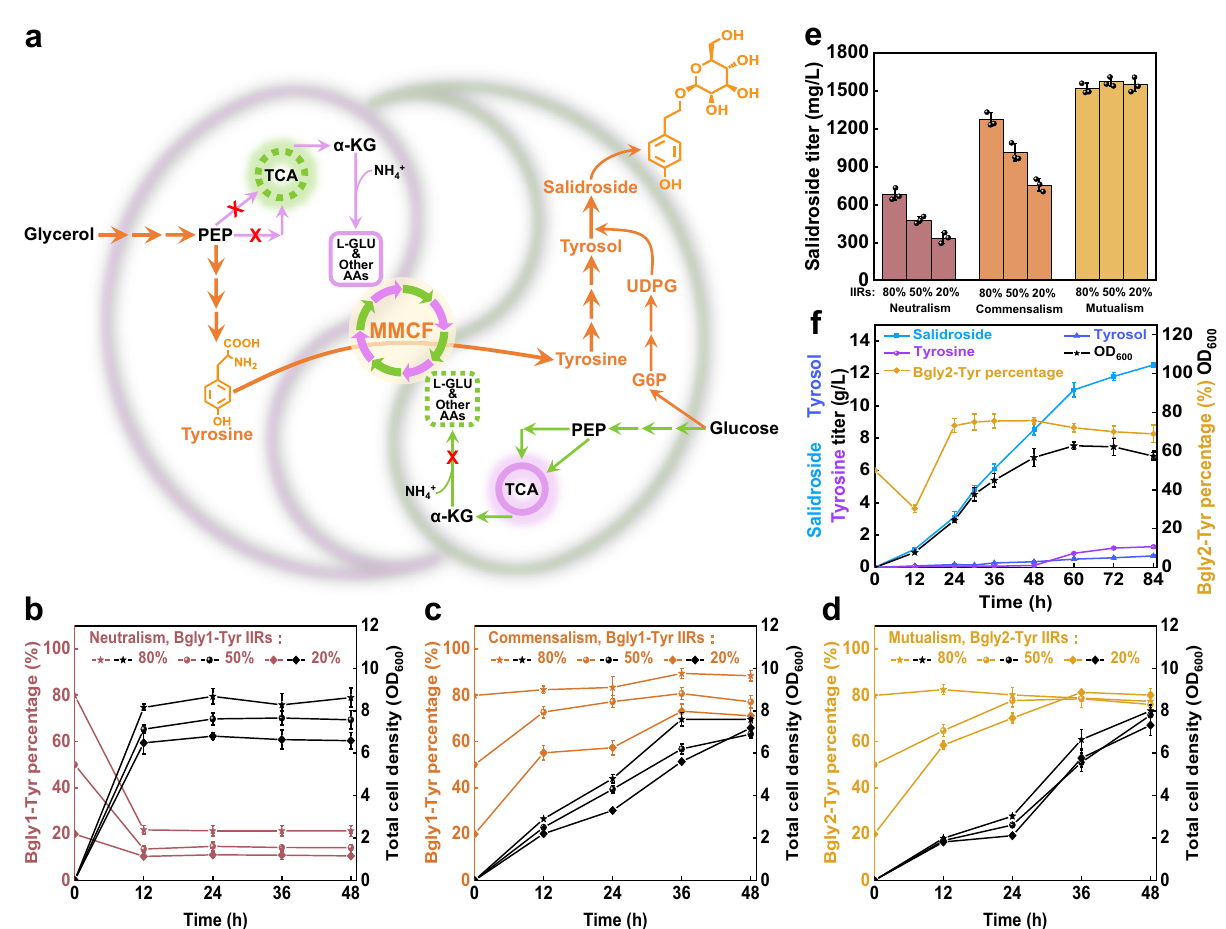
Fig. 3 Ef fi cient salidroside production and scale-up using coculture engineering. a Schematic of the E. coli-E. coli cocultures to accommodate the salidroside biosynthetic pathway and convert a glycerol and glucose mixture to salidroside (The salidroside biosynthetic pathway is shown in orange. For the detailed pathway, see Supplementary Fig. 5). Curves of cell growth and population change in b the Neutralistic Bgly1-Tyr/Bglc1-Sal coculture, c the Commensalistic Bgly1-Tyr/Bglc2-Sal coculture, and d the Mutualistic Bgly2-Tyr/Bglc2-Sal coculture. e Comparison of salidroside titers in the three coculture systems. f Scale-up production of salidroside using the Bgly2-Tyr/Bglc2-Sal coculture. MMCF multi-metabolite cross-feeding, IIRs the initial inoculation ratios. Metabolites: PEP phosphoenolpyruvate, G6P glucose-6-phosphate, UDPG uridine diphosphate glucose, α -KG α -ketoglutarate, L-GLU L-glutamate, AAs amino acids. Data shown are mean ± SD ( n = 3 independent experiments). Source data are provided as a Source Data fi